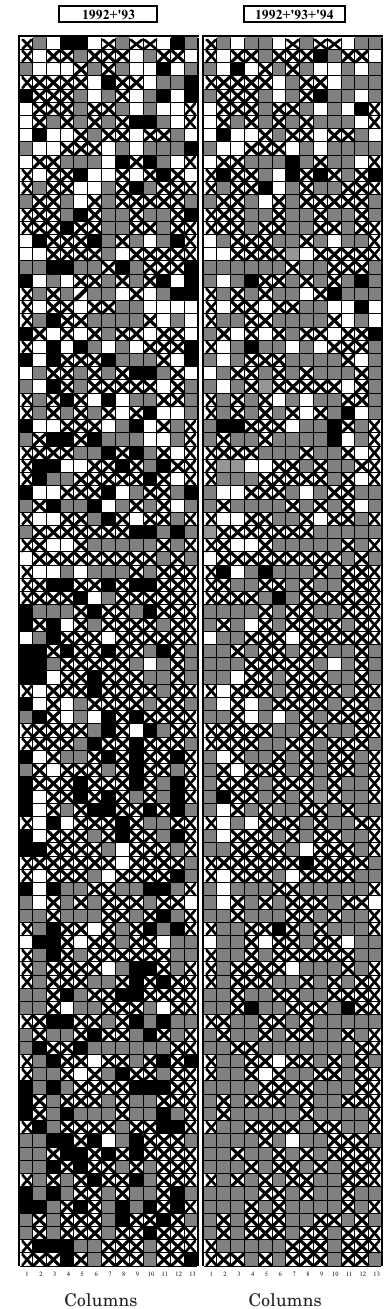
Fig. 1. Annual spatial pattern of esca-diseased plants in a vine- yard at San Casciano Val di Pesa in the province of Florence. Black squares, symptomatic plants; open squares, asympto- matic plants; “ X ”, plants died before start of survey (cause unknown); “ V ”, plants died during survey period, with or with- out esca symptoms in the previous year.